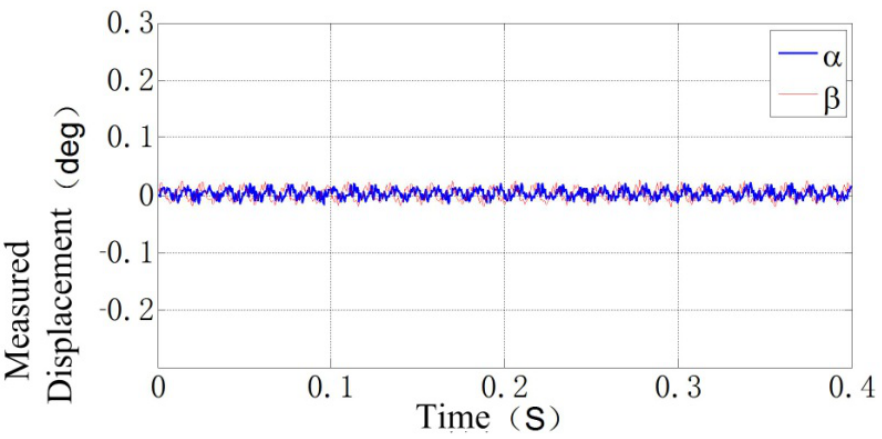
Figure 15. The rotor displacement locus measured by the designed dual-coil ECDS in α and β DOFs when the rotor rotates at 5,000